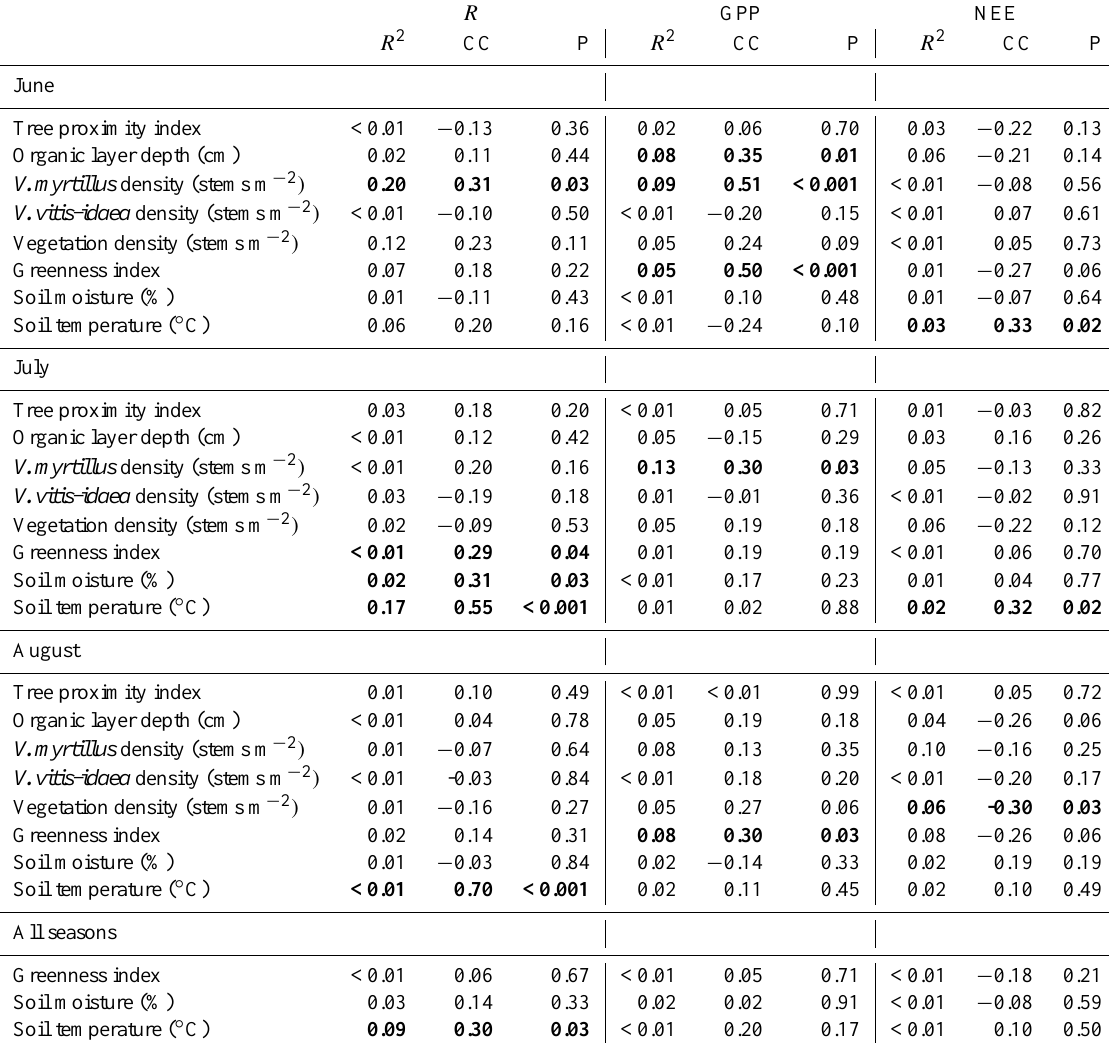
Table 2. Results of a Spearman’s rank correlation between forest floor CO 2 fluxes and a range of abiotic and biotic variables. Analyses across all seasons are run on the entire data set from the slopes of temporal change in variables transformed to control for spatial variation amongst locations. Significant correlations ( ≤ 0.05) are highlighted in bold. CC refers to the correlation coefficient, negative and positive CC values denote a negative and positive correlation